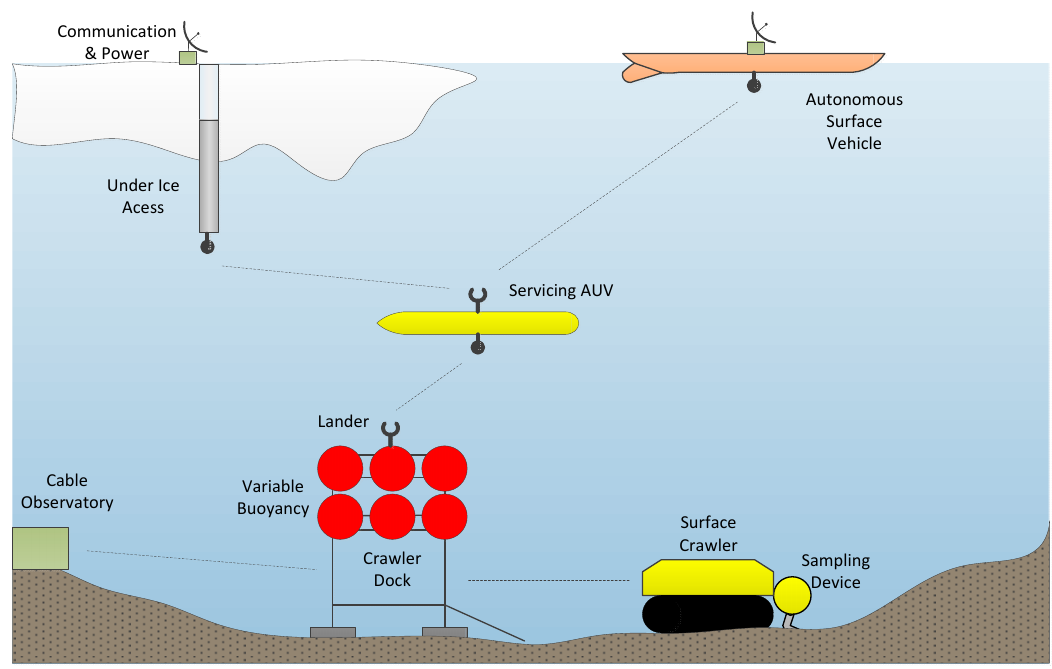
Figure 8. Concept for continuous temporal and spatial sampling. The sampling device is connected to a surface crawler, which has a limited operational range of around 2 km around the lander system. Continuous operation can be obtained by connecting the lander to a cabled observatory. The range and accessibility can be improved by using a servicing AUV. This also allows large-scale sampling with an Autonomous Surface Vehicle (ASV) or operations under ice.